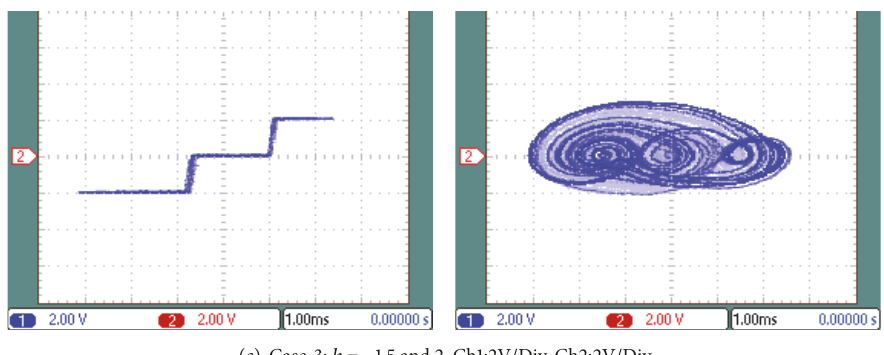
Figure 10: Experimental verification of optimized 3 scrolls using irregular SNLFs with different delays given in Table